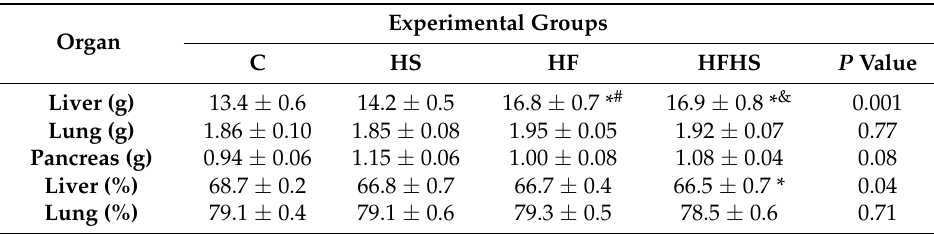
Table 3. Organ weights and water